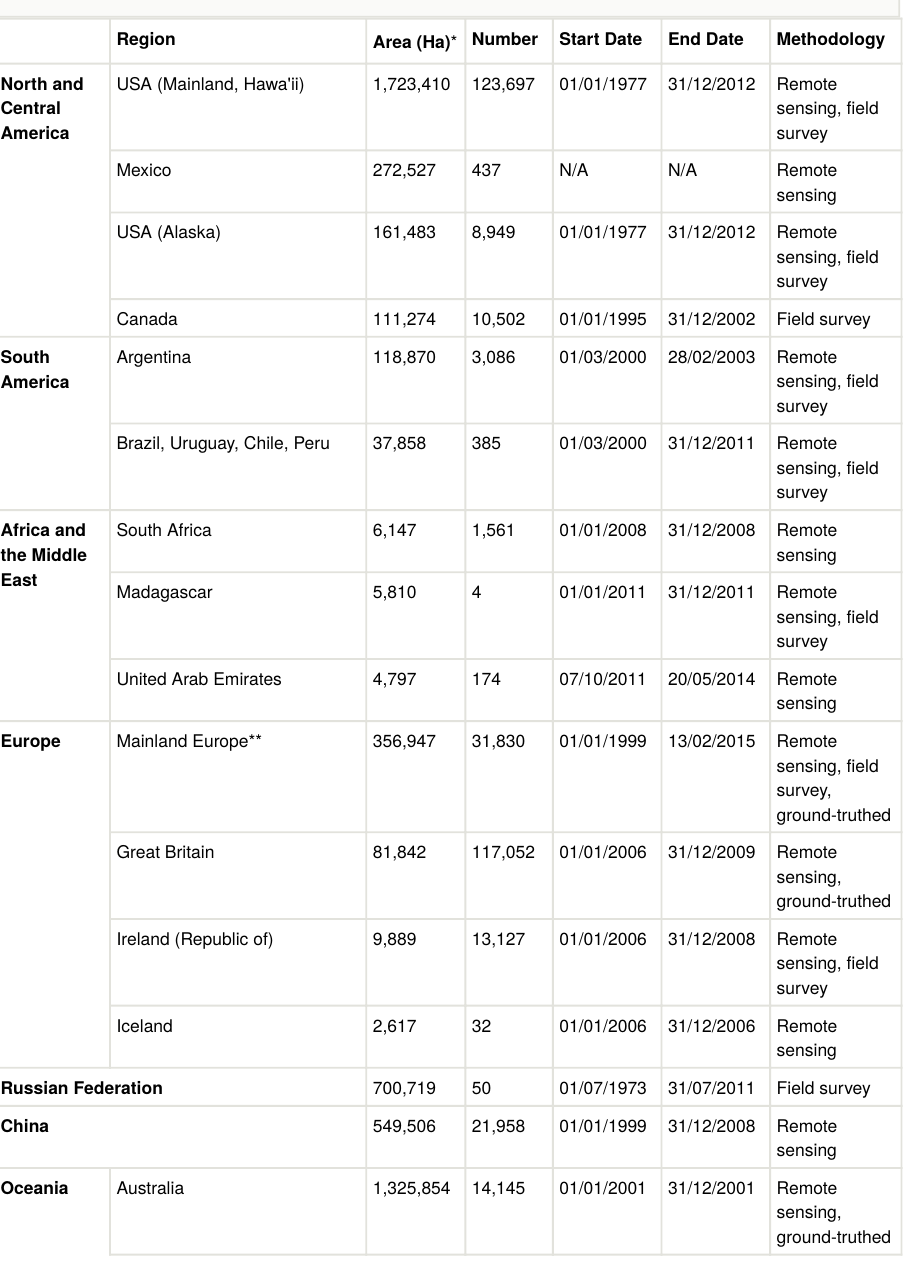
Table 1. Recorded salt marsh extent by region (in hectares), number of polygons, and time frame and high- level methodology of data collection, as derived from the “Global Distribution of Saltmarsh” polygon